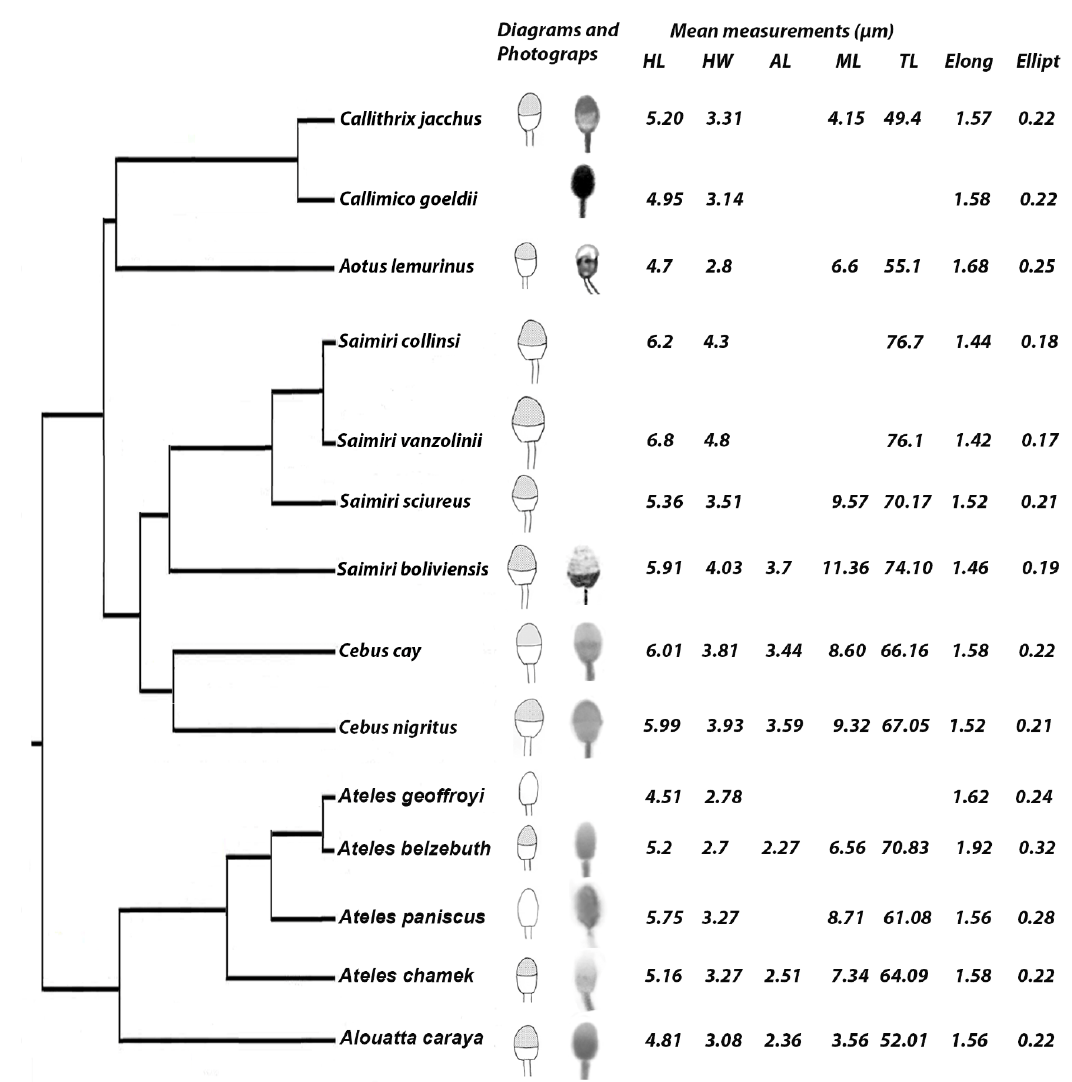
Figure 3. Evolution of sperm morphology and morphometry. Mean sperm measurements were superimposed on a phylogeny of neotropical primates (phylogeny from Dumas and Mazzoleni [33] with modifications [34–39]). When available, a scale diagram and/or microphotograph of the sperm head and proximal portion of the midpiece were provided for each species. Only species with data of head length and head width were included. HL: Head Length, HW: Head Width, AL: Acrosome Length, ML: Midpiece Length, TL: Total Length, Ellipt: Ellipticity = (HL/HW), Elong: Elongation = ((HL − HW)/(HL + HW)). Cebus cay = Sapajus cay; Cebus nigritus = Sapajus nigritus.